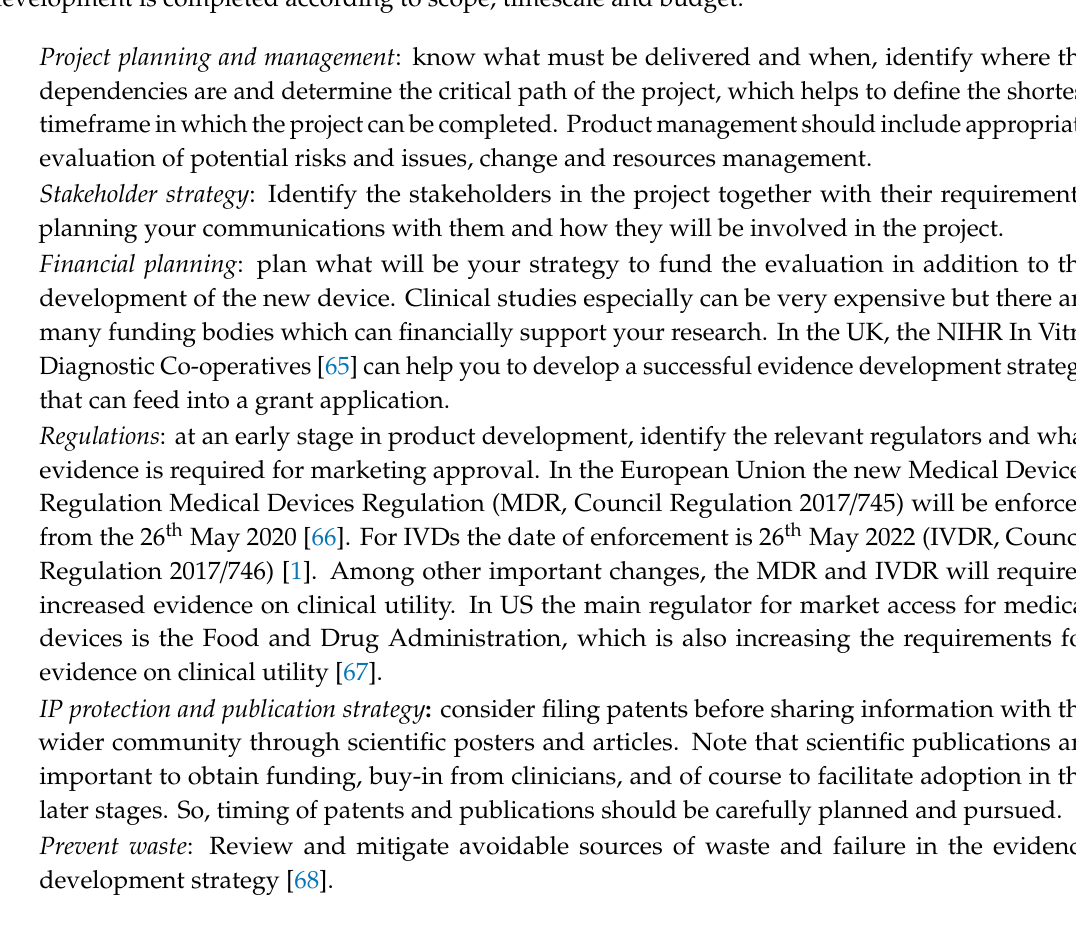
Table 6. Comparison of evaluation study methodologies for IVDs and DHTs. Evaluation Question IVD Methodology Maps to DHT Tier Does the device perform as expected Analytical validity ↔ Tier 1 in the development laboratory? Does the device perform as Clinical validity ↔ Tier 2 expected in the real world? Does the device provide value to Clinical utility ↔ Tier patients and the healthcare system?